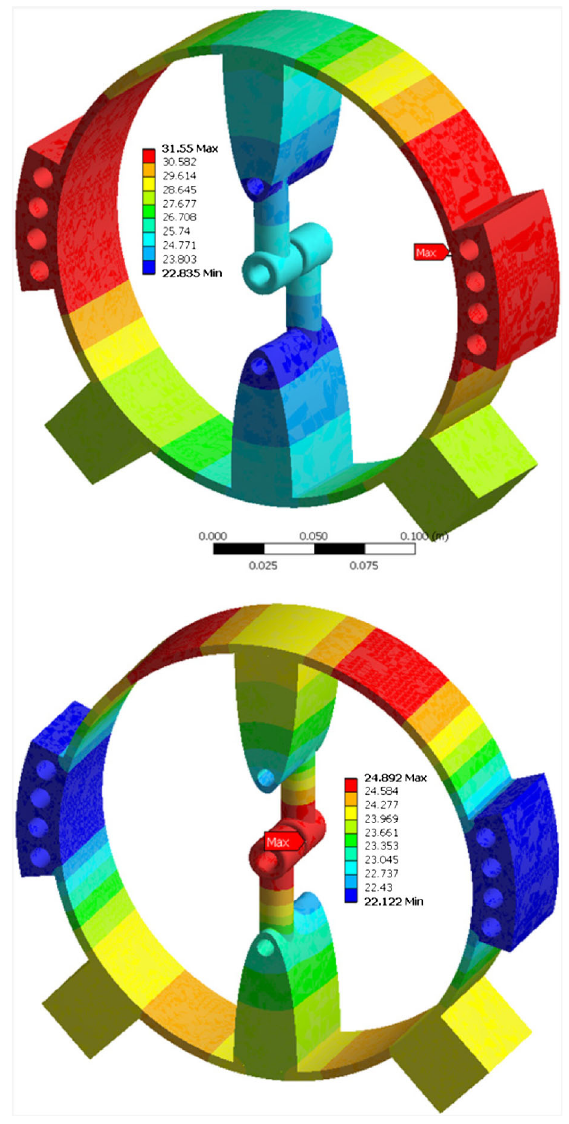
FIG. 4. Temperature distribution in one period of regular copper IH structure with water cooling in vanes only (top), and both in vanes and outer manifolds